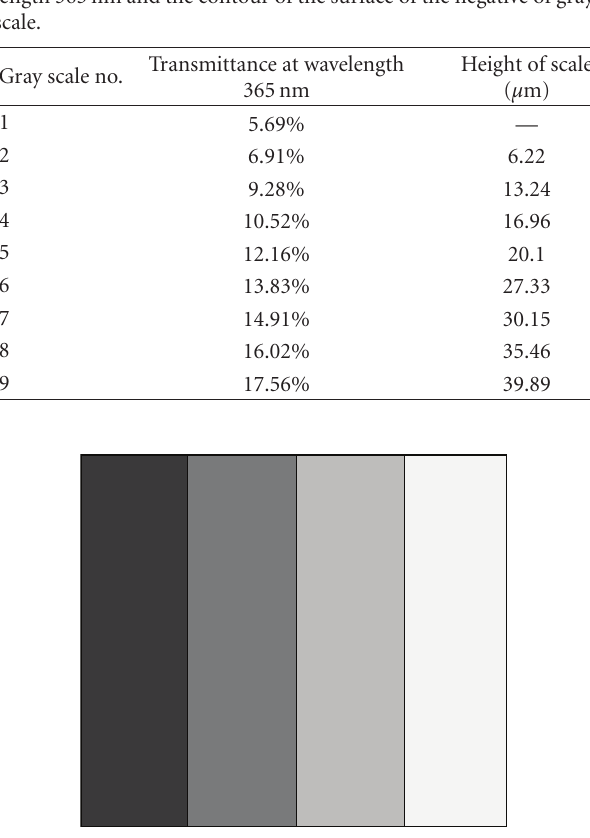
Figure 9: Arrangement of gray scale image.